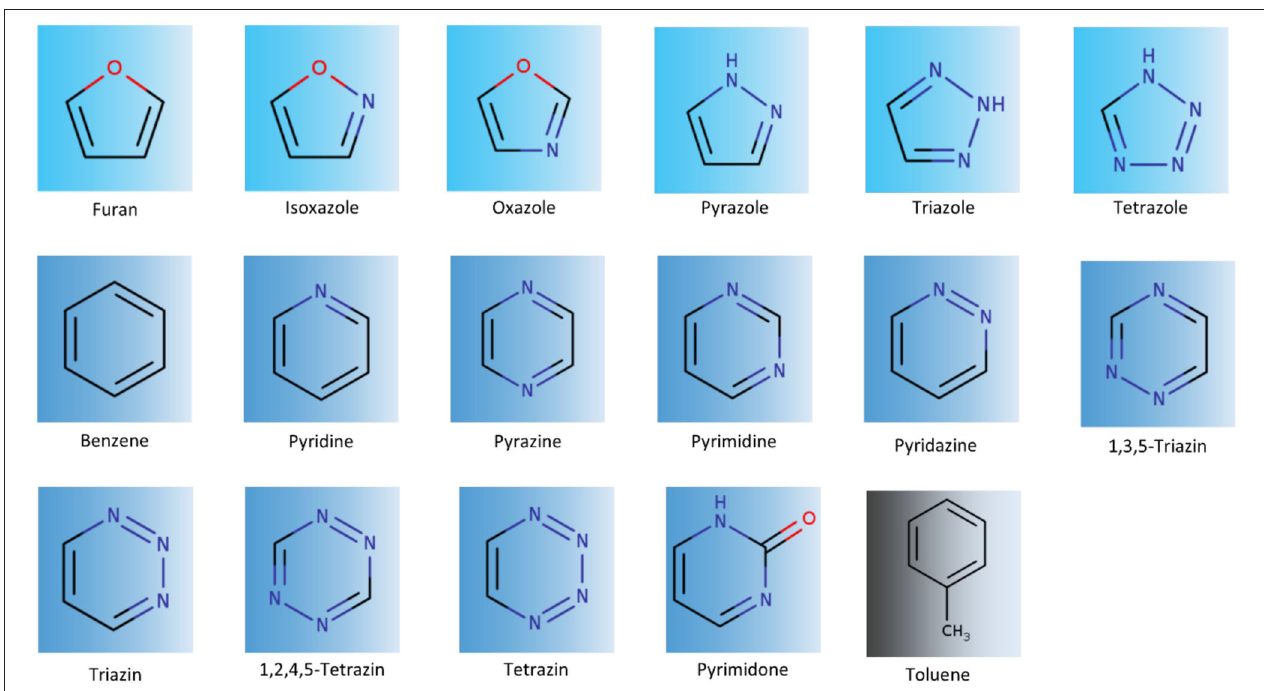
FIGURE 1 | Overview of the analyzed aromatic molecules. Simulations were performed to investigate stacking interactions with toluene. We analyzed 5-membered heteroaromatics, furan, isoxazole, oxazole, pyrazole, triazole, and tetrazole. Furthermore, we simulated 6-membered rings, benzene, pyridine, pyrazine, pyrimidine, pyridazine, variants of triazine, and tetrazine, and